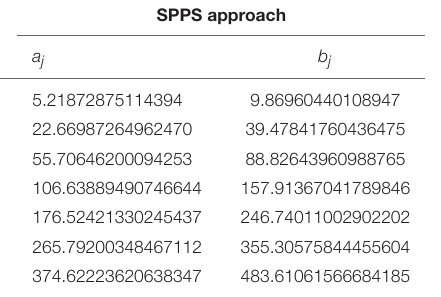
TABLE 1 | Some spectral bands of the Kronig-Penney model calculated from the SPPS approach and the exact expression (28). SPPS approach Exact Kronig-Penney expression Absolute